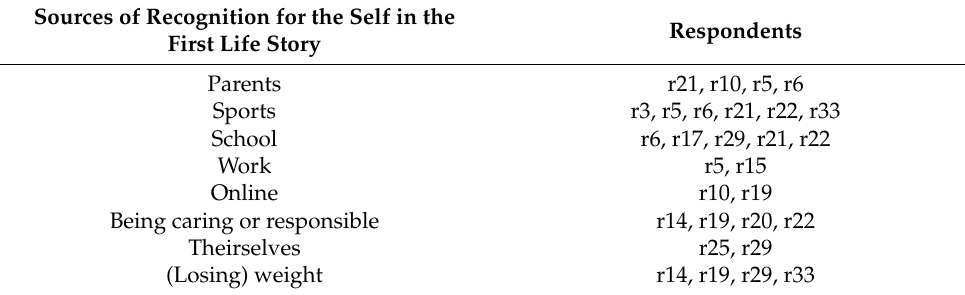
Table 3. Sources of recognition in the first life